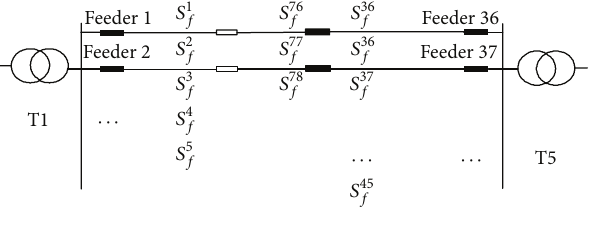
Figure 5: Local topology related with f 1 .